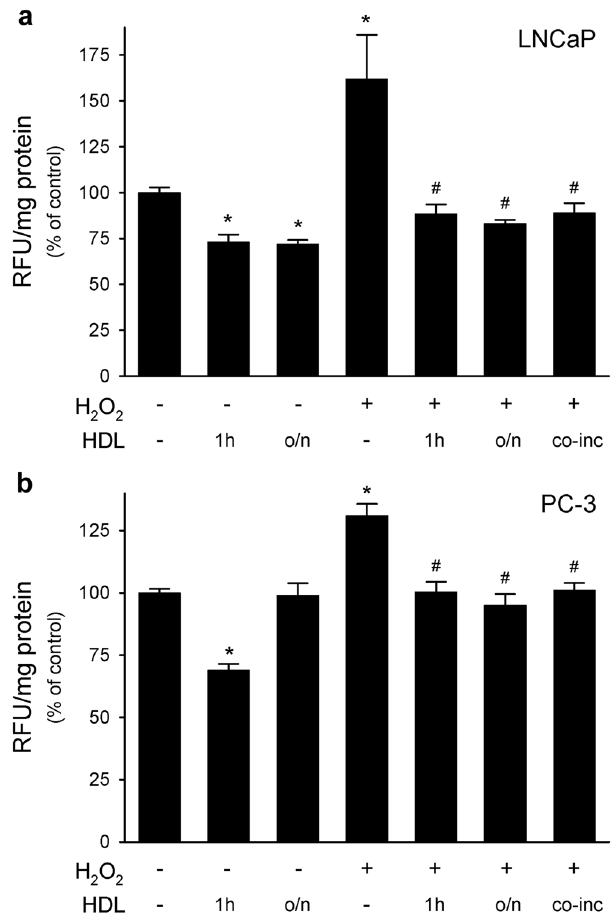
Figure 1. HDL reduced ROS production in LNCaP and PC-3 cell lines. LNCaP (Panel a) and PC-3 cells (Panel b) were pre-treated overnight (o/n) or for 1 h with HDL 0.5 mg/ml and then stimulated or not with 0.5 mM H 2 O